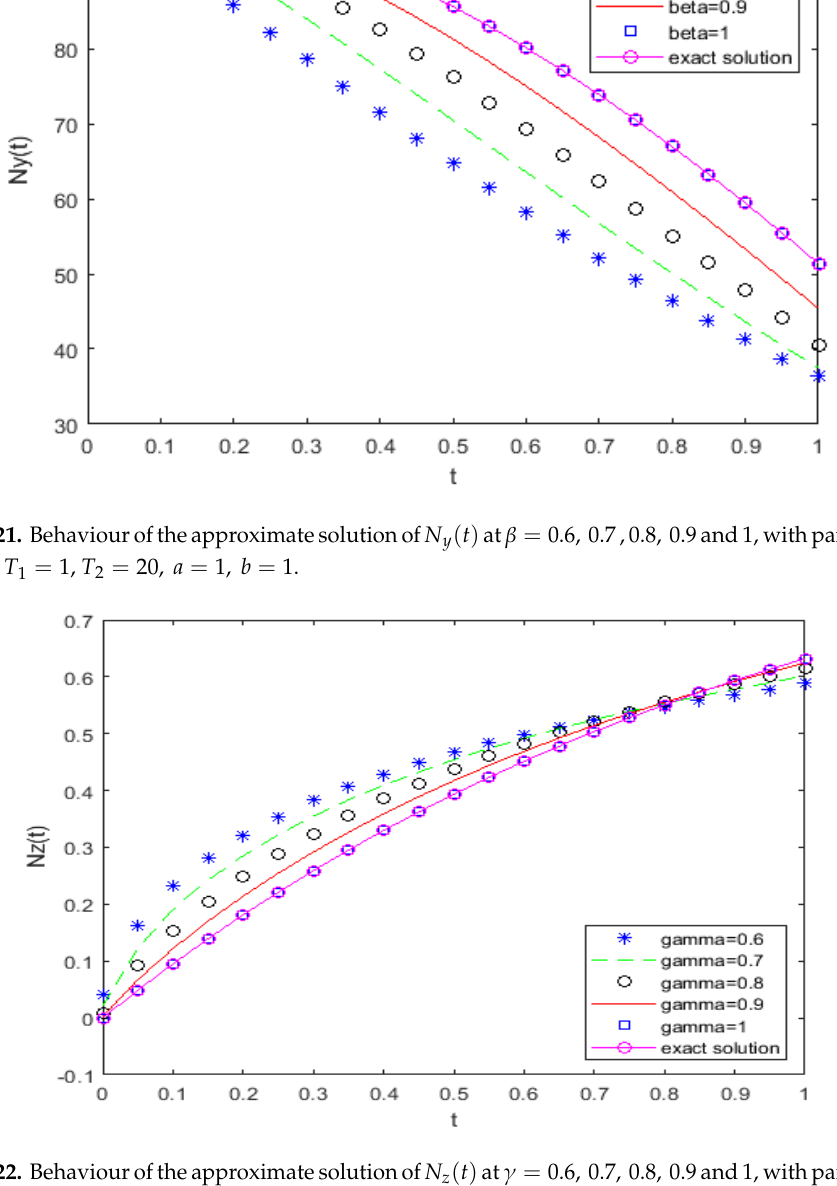
Table 1. Comparison of ( 𝑙 (cid:2998) ) and ( 𝑙 (cid:2870) ) errors at 𝑎 = 𝑏 = 0.8 , 𝑚 = 5, 8 for integer order solution. 𝑵 (𝒕) 𝒎 = 𝟓 𝒎 = 𝟖 𝒊